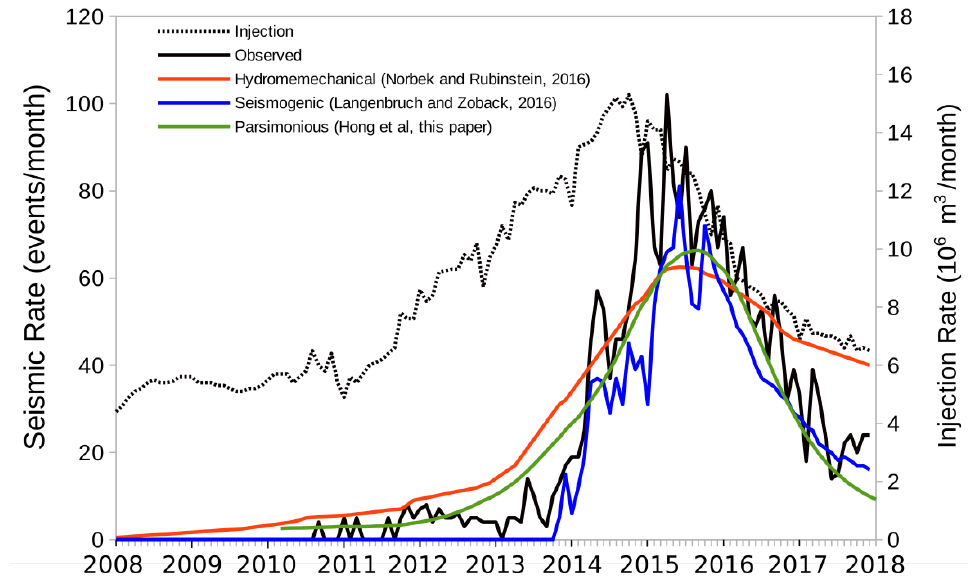
Figure 9. Model intercomparison experiment using the hydromechanical, seismogenic and parsimonious models for retrospective simulations of seismicity in Oklahoma between 2008 and 2018 in light of observed (declustered) seismic events and monthly waste water injection